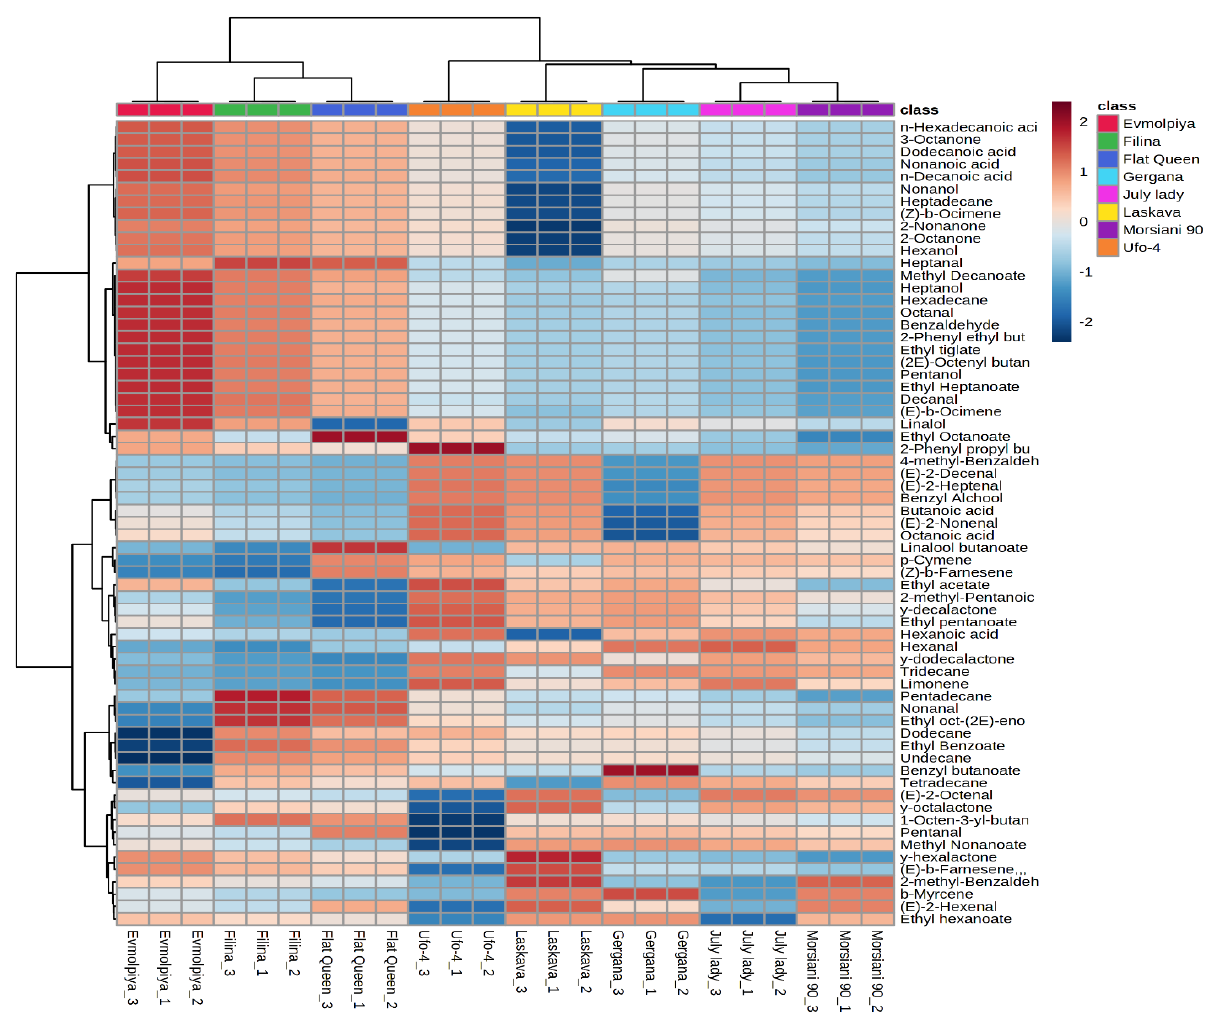
Figure 7. Clustering result of peach varieties shown as a heatmap. The color scale of the heat map ranges from dark brown (value, +2) to dark blue (value, − 2). The values were normalized by log 10 transformation.